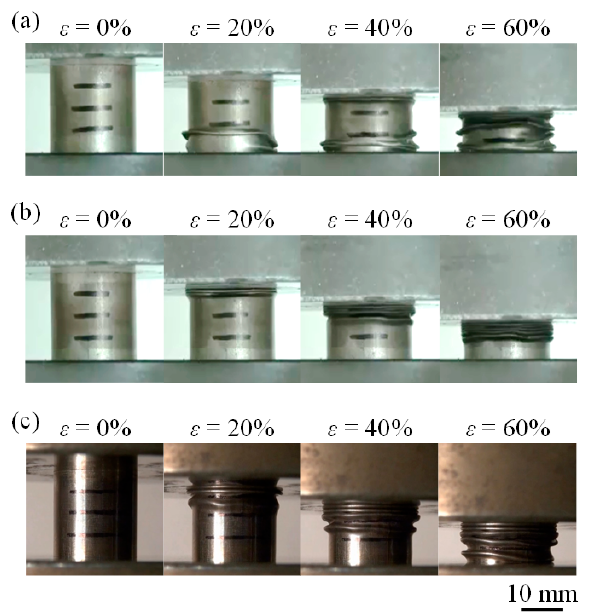
Figure 8. Deformation behavior during compression test of the fabricated Al foam-filled steel tube with ( a ) p = 79.3%, corresponding to Figure 5b,c. ( b ) p = 90.2%, corresponding to Figure 5d,c Al foam-filled steel tube fabricated using bulk Al precursor with ( c ) p = 84.5%.